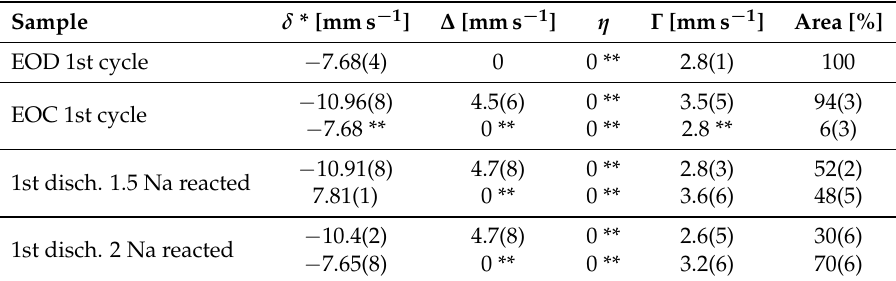
Table 5. Ex situ 121 Sb hyperfine parameters at 78K for the cycled Sb electrodes.